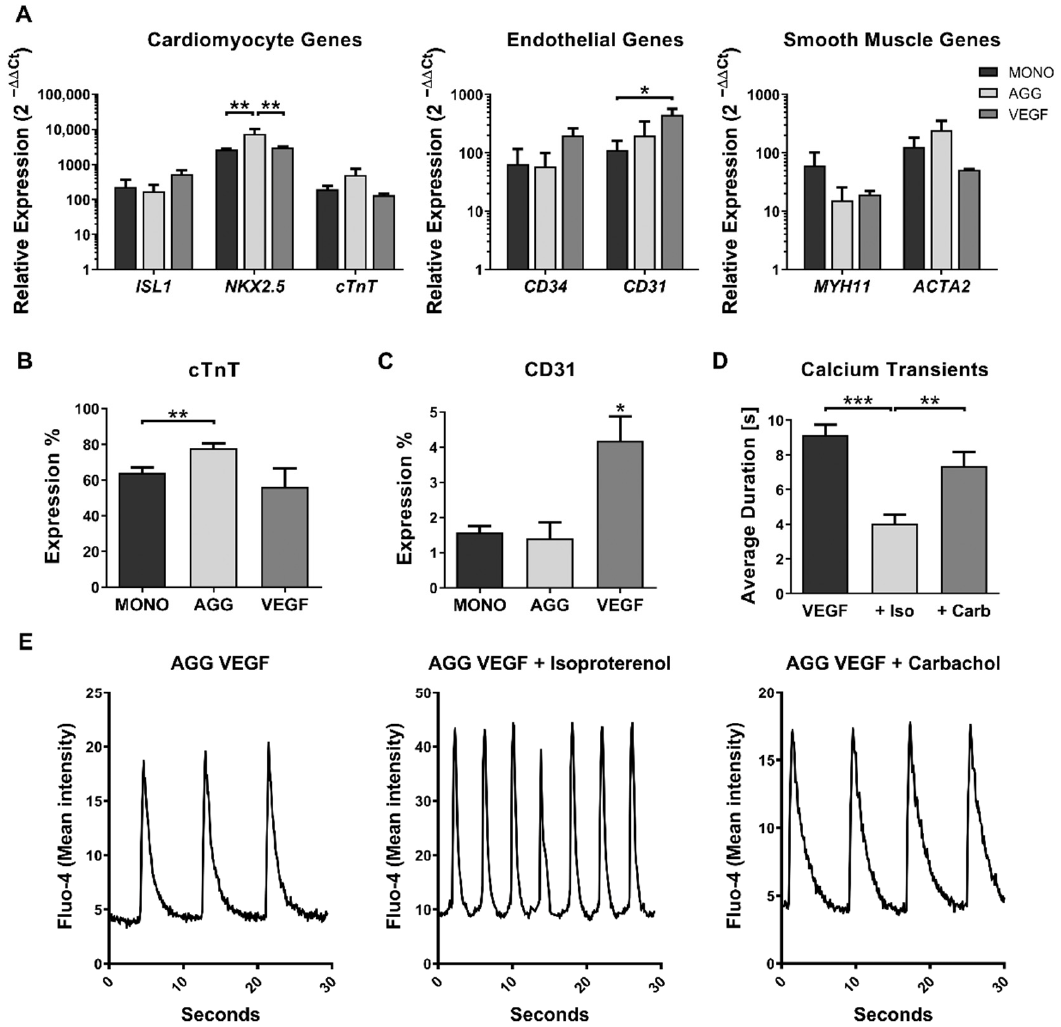
Figure 3. Aggregate characterization by analysis of lineage markers using real-time PCR, flow cytometry, and calcium transient microscopy. ( A ) Analysis of lineage markers gene expression by real- time PCR. Most genes expression was not significantly different between the monolayer (MONO), aggregates (AGG), and aggregates supplemented with VEGF (VEGF). Addition of VEGF signifi- cantly increased the expression of CD31 . Error bars, SEM, n = 3. * p -value < 0.05, ** p -value < 0.01 (2- way ANOVA with Tukey’s test). ( B ) Flow cytometry showed an increase in cTnT-positive cells for aggregates without VEGF compared with the monolayer and aggregates supplemented with VEGF. Error bars, SEM, n = 6 for MONO, n = 4 for AGG and n = 3 for VEGF. ** p -value < 0.01 (Welch’s t - test). ( C ) CD31 protein expression increased over two-fold when a double dosage of VEGF was supplemented compared with the monolayer and aggregates without VEGF. Error bars, SEM, n = 7 for MONO, n = 6 for AGG, and n = 3 for VEGF. * p -value < 0.05 (Welch’s t -test). ( D ) Calcium transient analysis of aggregates supplemented with VEGF. The average time between calcium transients demonstrates a strong statistically significant decrease from 9.1 s to 4.0 s when isoproterenol (+Iso) was used. Carbachol (+Carb) showed no statistically significant effects (7.3 s). Error bars, SEM, n = 10 for VEGF, n = 8 for +Iso, n = 7 for +Carb. ** p -value < 0.01, *** p -value < 0.001 (Welch’s t -test). ( E ) Representative calcium transient profiles. Left, aggregates supplemented with VEGF (8.5 s, SD ± 0.1), middle, when 1 µM isoproterenol was supplemented (4.0 s, SD ± 0.1), and right, when 1 µM carbachol was supplemented (8.0 s, SD ± 0.1). Flow cytometry analysis of the cTnT marker (Figure 3B) showed an increase in the percentage of cells expressing this marker in aggregates, with 78% cTnT-positive cells, when compared to monolayer, with 64%, which is in accordance with the gene expression observed for the cardiomyocyte panel (Figure 3A). In addition, in agreement with the PCR results, VEGF supplementation resulted in a significantly increased expression of CD31,